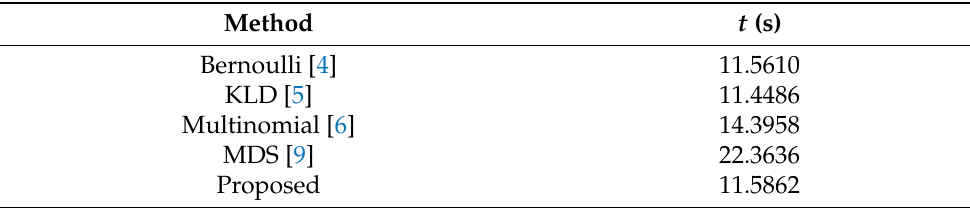
Table 2. Comparison of the average run times when S = 30 with BCH (15, 11)